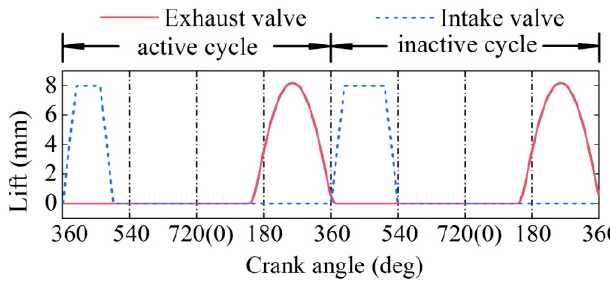
Figure 2. The schematic of the valve strategy based on fresh air trapping.